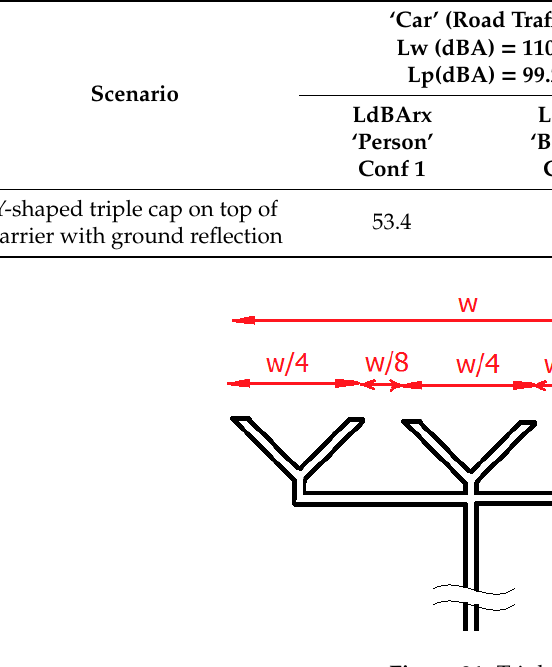
Table 3. Global SPL (dBA) at the receiver positions for Y-shaped triple caps.